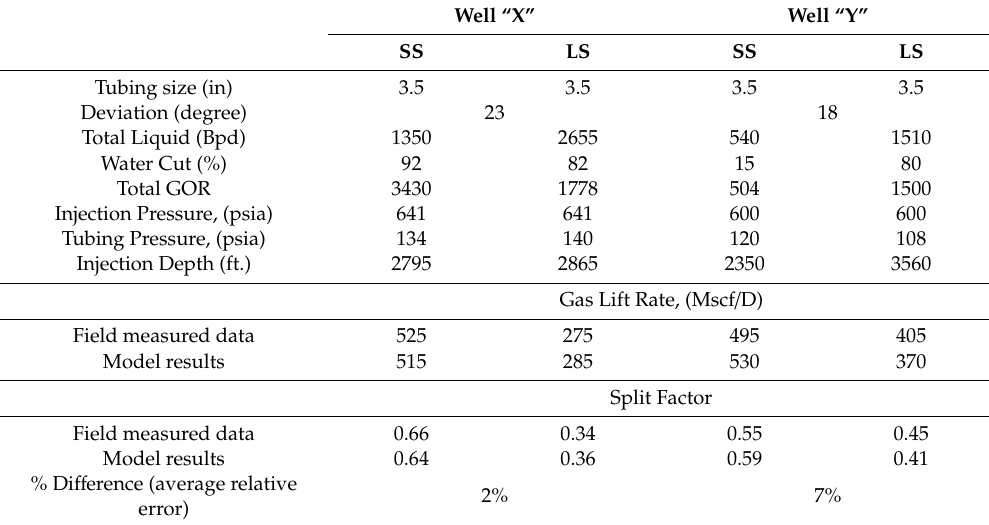
Table 3. Comparison of model results and measured